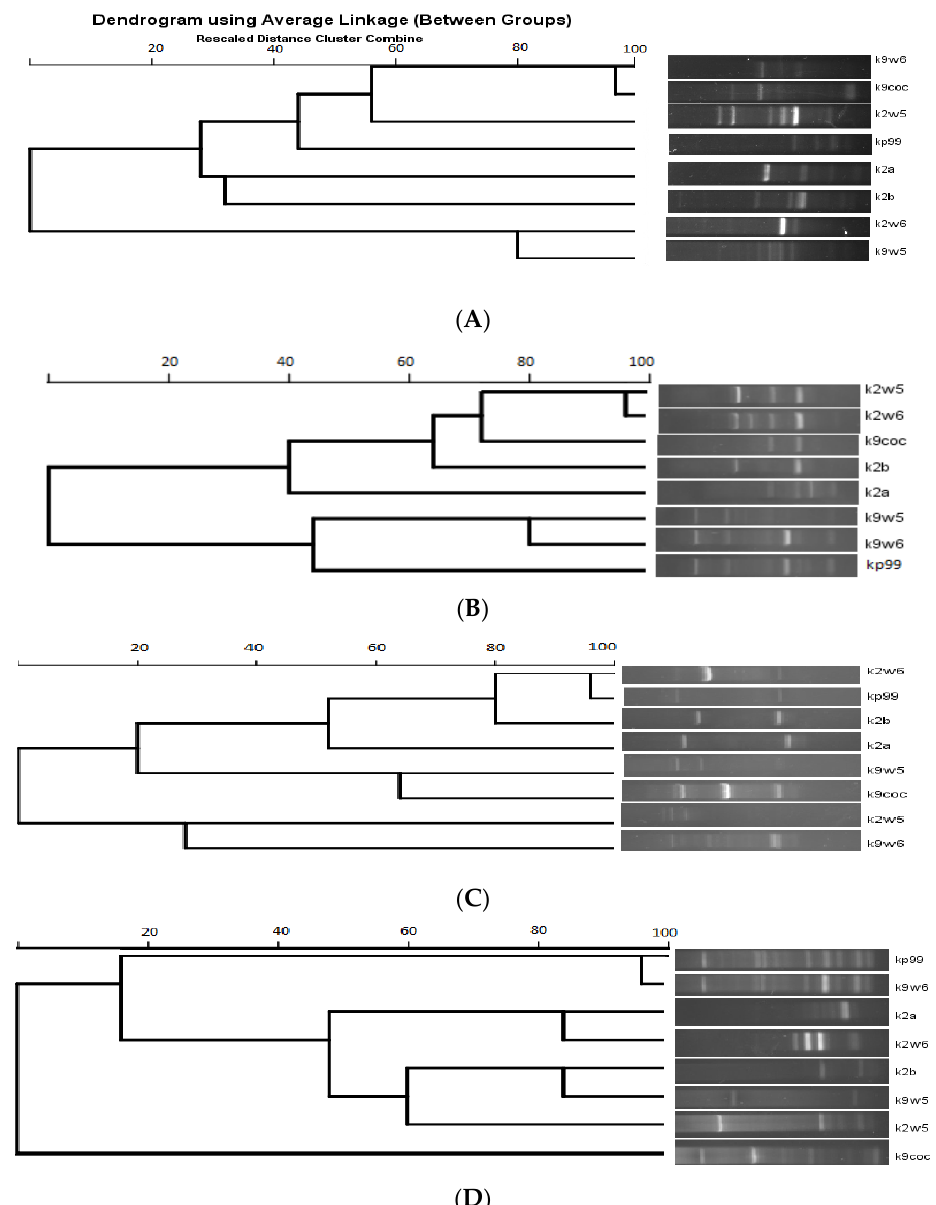
Figure 7. Dendrogram of eight K. pneumoniae bacteriophages. ( A ) RAPD primer R10. ( B ) RAPD primer 5. ( C ) RAPD primer 2. ( D ) RAPD primer 1.